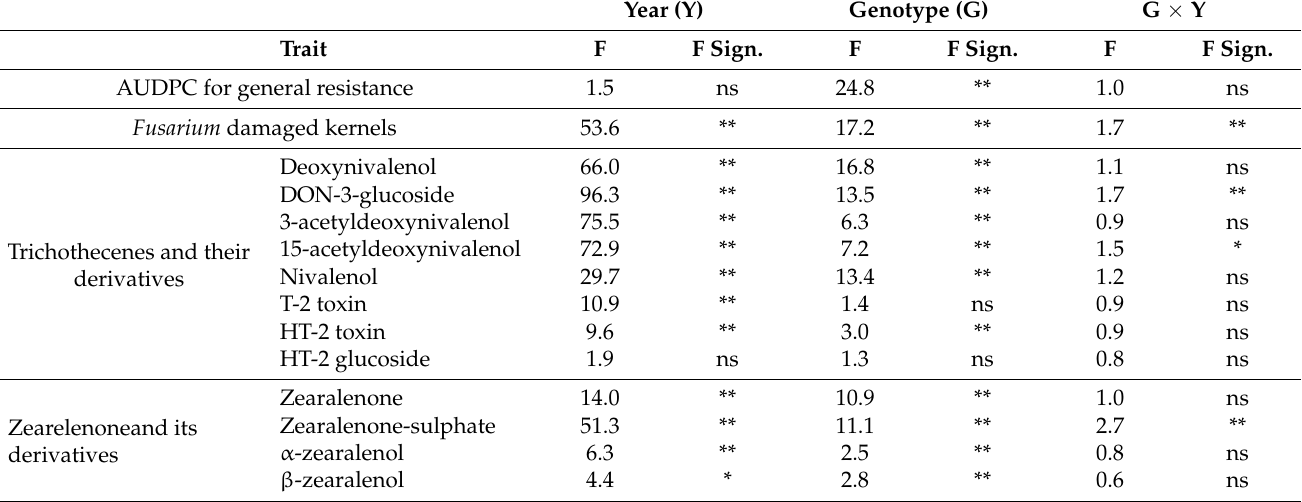
Table 1. Analysis of variance for area under the disease progress curve (AUDPC) for general resistance, Fusarium damaged kernels (FDK), and content of 28 mycotoxins in grain of 36 wheat genotypes grown in three vegetation years; F values and their significances (F Sign.) are shown. Year (Y) Genotype (G) G × Y Trait F F Sign. F F Sign. F F